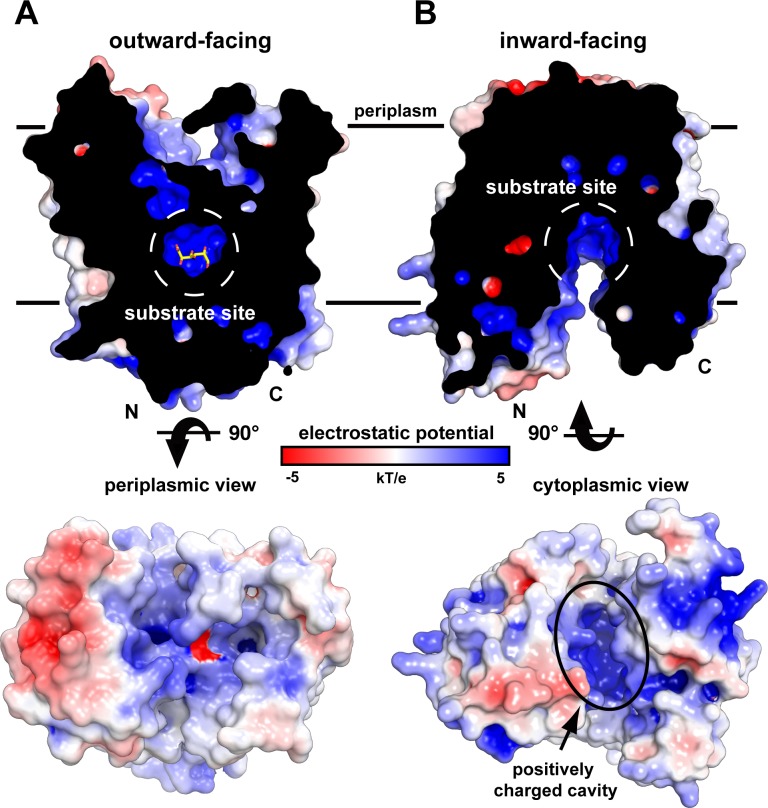
The structures of DgoT include substrate-bound outward-facing occluded and apo-, inward-facing open conformations.DgoT crystal structures shown in electrostatic surface potential representation. (A) A cross section through DgoT in the outward-facing occluded conformation shows galactonate (sticks) bound within the substrate recognition site (dashed white circle). The electrostatic potential of the periplasmic surface is shown below. (B) A cross section of DgoT in the inward-facing open conformation reveals an aqueous cavity with net positive surface charge. The electrostatic potential of the cytoplasmic surface is shown below. Both views highlight the positively charged binding site. DgoT, D-galactonate transporter.